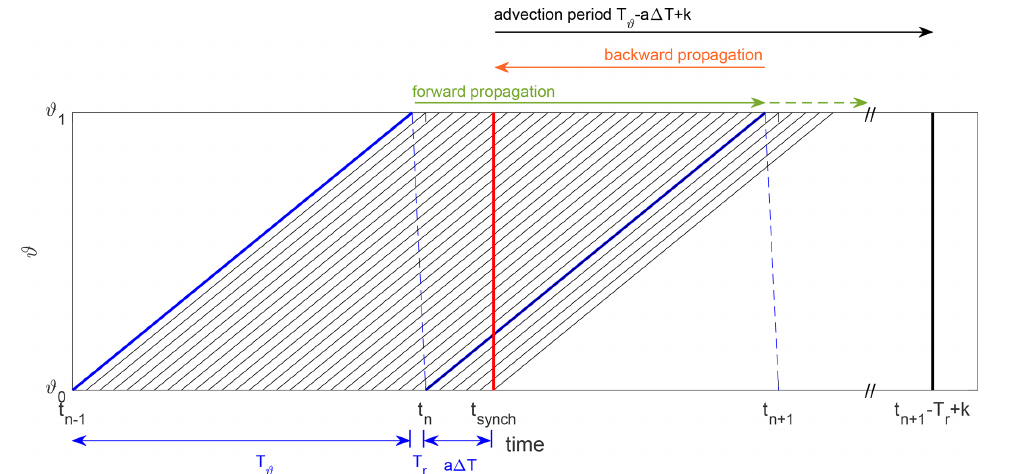
Figure 4. Time synchronization of the lidar scan initialized at t n shown in blue to time t syn = t n + a (cid:49)T shown in red. The scanning domain is here visualized as azimuth angle ϑ over time. The synchronized scan is interpolated using propagated lidar scans with a temporal resolution of (cid:49)T . The measurement reset time T r is indicated as the dashed blue line. Propagated scans, which are shown in grey, are a combination of a forward and backward propagation weighted according to a trigonometric function. Green and orange arrows above the figure indicate to which of the propagated scans both forward and backward propagation and to which only a forward propagation contributes. The synchronized scan at t syn can thus be reconstructed using only the two consecutive lidar scans initialized at t n and t n − 1 . t syn should be chosen to minimize the wind vector advection period to the forecast time t n + 1 − T r + k with lead time k , indicated as a black arrow. Figure adapted from Beck and Kühn